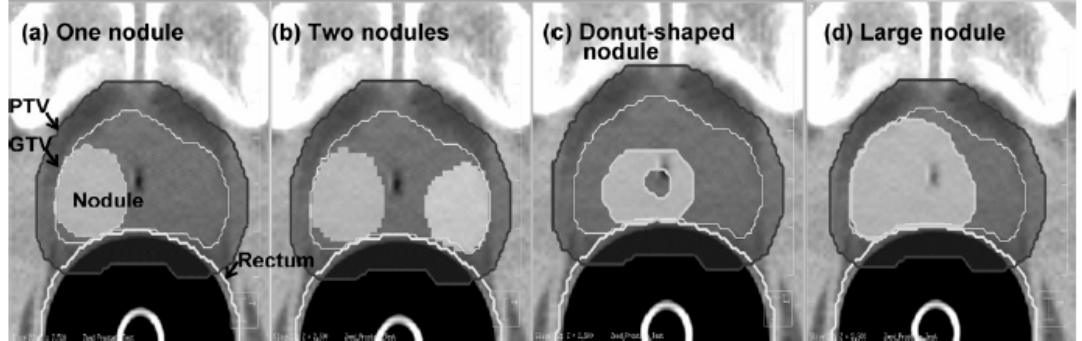
Figure 4. Subvolume (nodule) geometries. ( a ) One-nodule case, ( b ) two-nodule-case, ( c ) donut-shaped-nodule case, ( d ) big-nodule case. Reproduced with permission from [51].